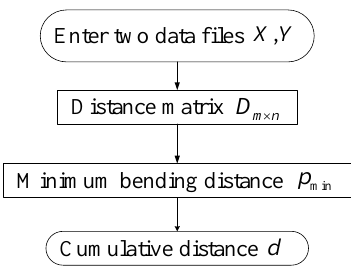
Figure 7. Dynamic time warping (DTW) implementation flow chart.